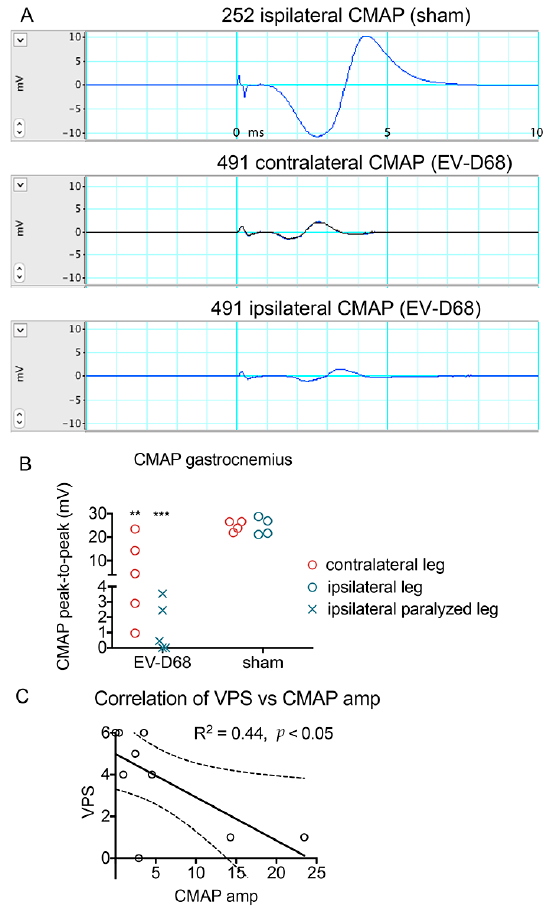
Figure 2. Deficits in Compound Muscle Action Potential (CMAP) amplitudes of EV-D68-infected AG129 mice 6 weeks after onset of paralysis. Blue and black lines are electrical potential tracings. ( A ) Examples of CMAP from sham-injected mouse (#252 ipsilateral), and from an EV-D68-injected mouse (#491) with no paralysis on the contralateral hindlimb and paralysis on the ipsilateral hindlimb; ( B ) CMAP amplitudes of gastrocnemius muscle of sham- and EV-D68-injected mice. Ipsilateral legs of infected mice were all paralyzed (“×” symbol). ( C ) Correlation of VPS and CMAP of infected mice only. Solid line represents linear regression analysis. Dotted lines represent 95% confidence interval. ** p < 0.01, *** p < 0.001 compared to respective sham controls using t -test.